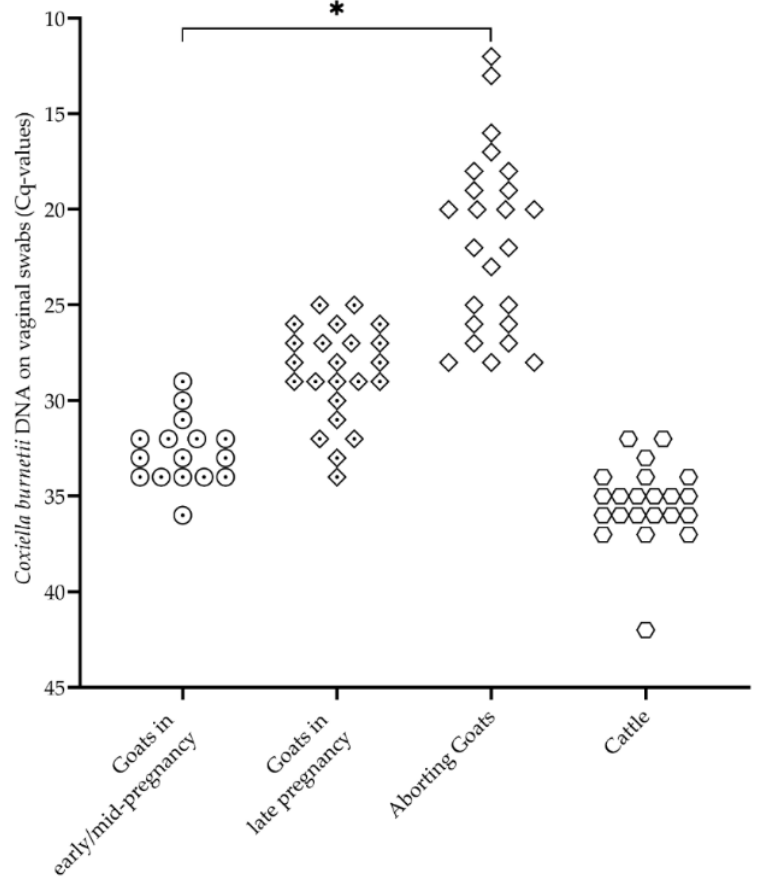
Figure 2. Coxiella burnetii DNA on vaginal swabs from three goat groups with different reproductive statuses (goats in early/mid-pregnancy ⊙ ( n = 16), goats in late pregnancy ⟐ ( n = 23), aborted goats ◇ ( n = 24)) and cattle ⎔ ( n = 22). Each point represents the qPCR result (Cq-value) of an animal. * Significant differences between the three groups of goats ( p < 0.05).